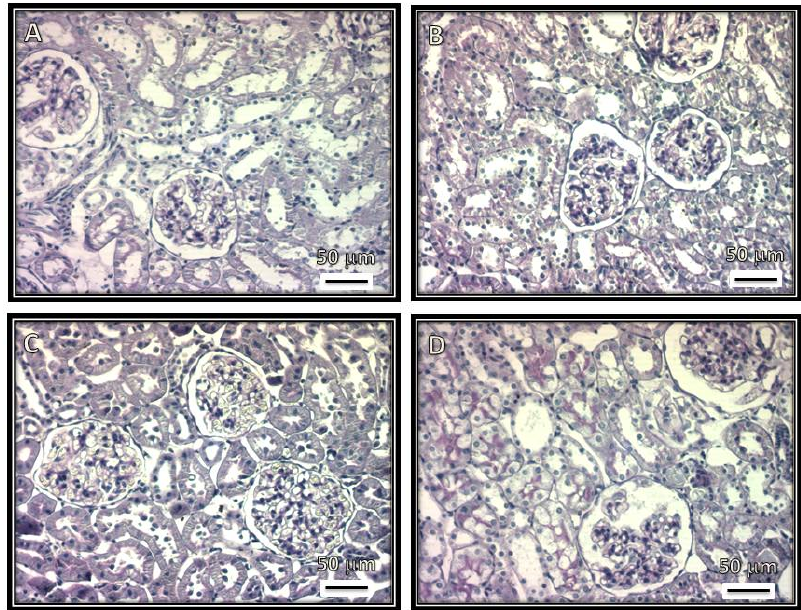
Figure 2. Representative photomicrographs of rat renal cortexes. ( A ) Control. ( B ) Kidneys from rats injected with saline solution, and ( C ) rats receiving serum from healthy subjects. Open capillary loops, basement membranes and Bowman’s capsule positive for PAS staining are observed in these panels. ( D ) Kidneys from rats receiving serum from patients with CG. Retraction of the glomerular tuft, podocyte hypertrophy and injury and increased urinary space are observed, and there are some vacuoles in the urinary space. (Periodic acid–Schiff stains, 200×.)